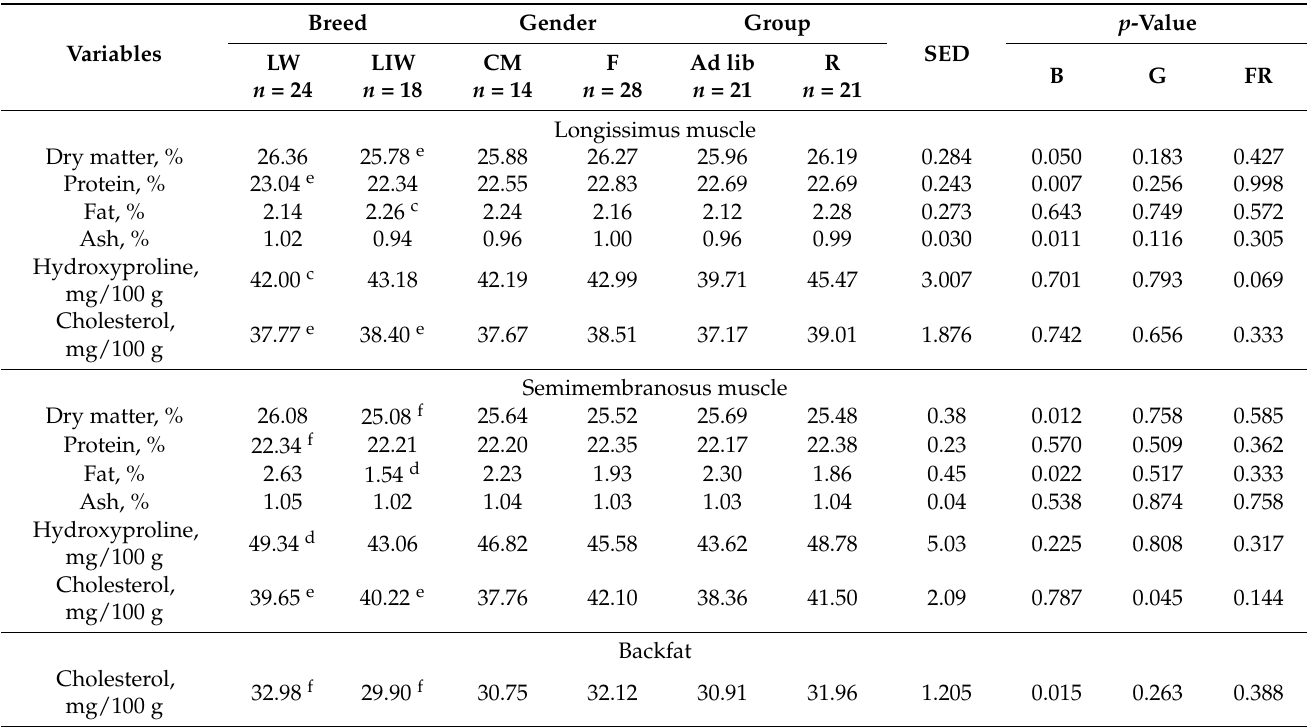
Table 5. Effects of breed, gender, and feeding regimen during the finishing phase on the chemical composition of pig muscles.